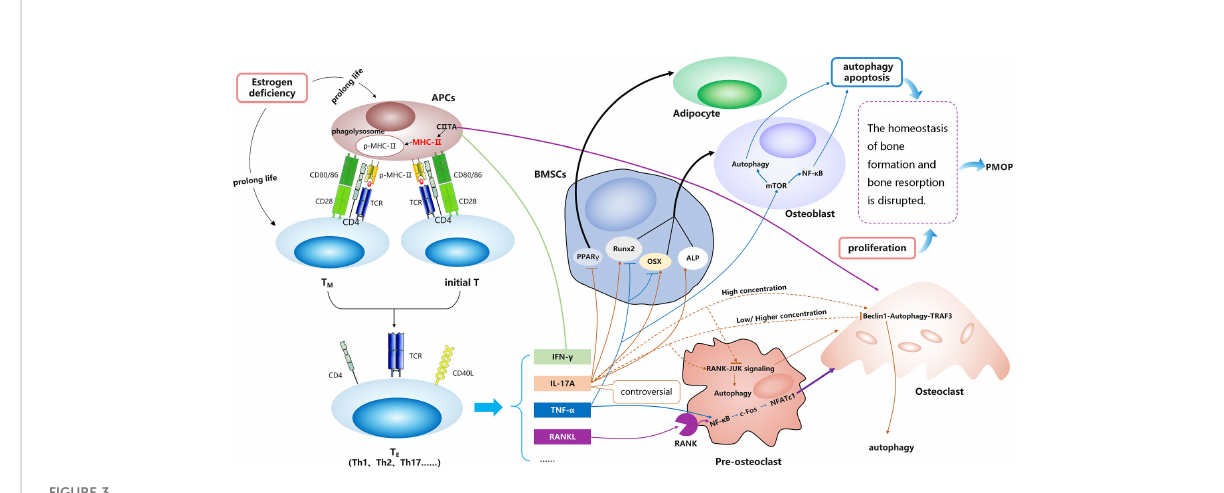
FIGURE 3 The relationship between MHC-II and